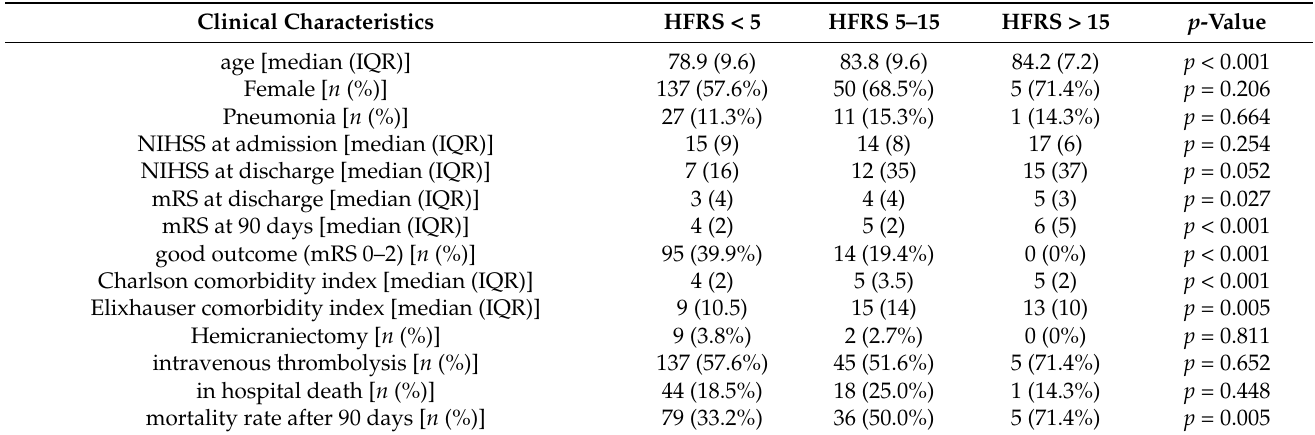
Table 3. Clinical characteristics of the different frailty groups.